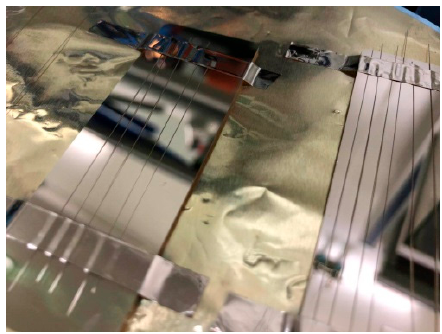
Figure 6. Gold-plated optical fiber.